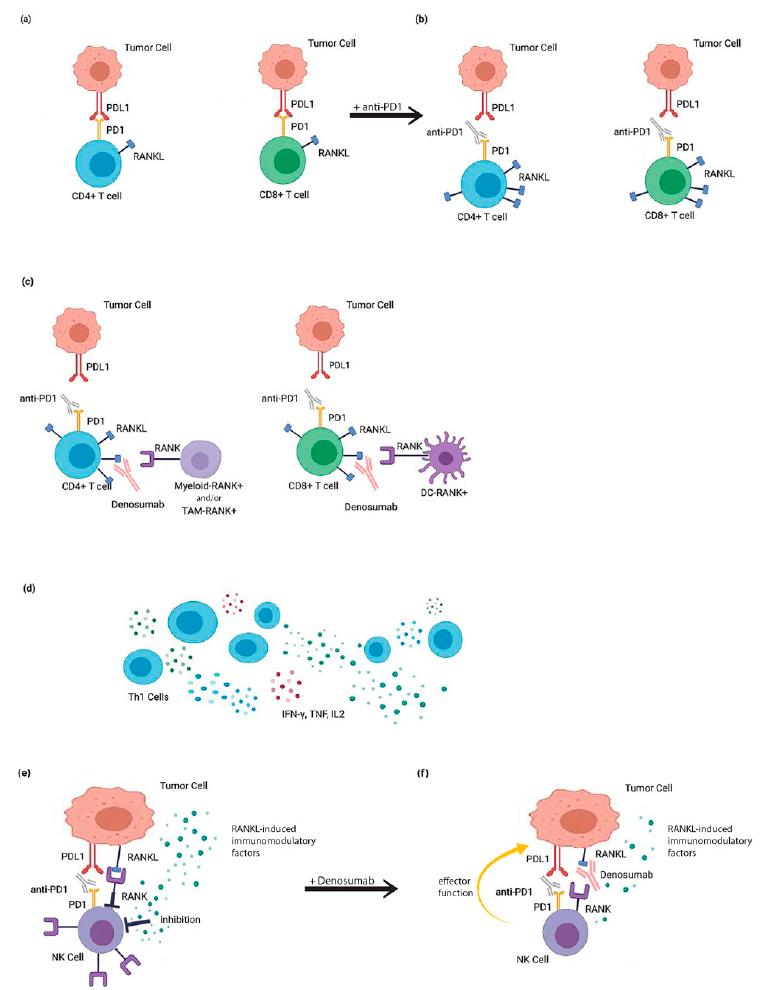
Figure 1. Coinhibition of receptor activator of nuclear factor- κ B ligand (RANK) and immune checkpoint inhibitors (ICIs) in order to overcome primary resistance in RANK-positive breast cancer cells. ( a ) PD1–PDL1 interaction between RANK ( + ) BC cells and RANKL( + ) CD4 + and CD8 (BC) cells. ( a ) PD1–PDL1 interaction between RANK (+) BC cells and RANKL(+) CD4+ and CD8+ T-